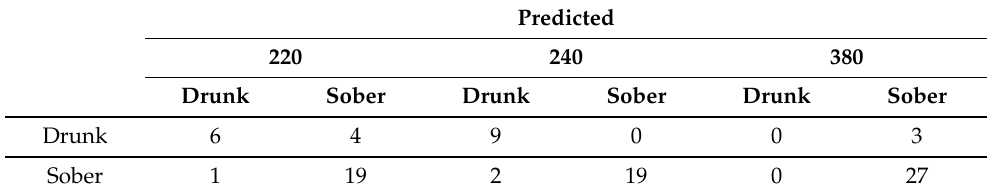
Table 3. Confusion matrices of the Gradient Boosting classifier for BrAC thresholds of 220, 240, and 380.